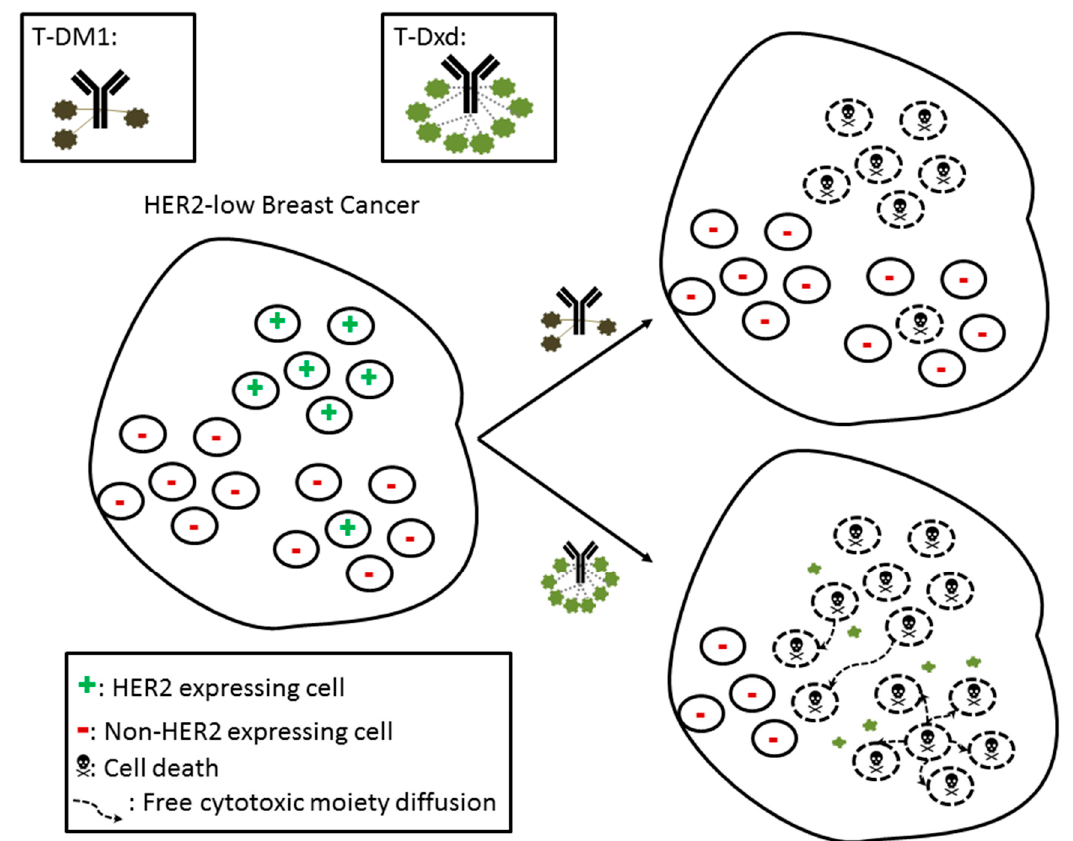
Figure 1. Schematic representation of HER2-low breast cancer being exposed to trastuzumab–emtansine (T-DM1; top of figure), with its non-cleavable linker attaching trastuzumab to the cytotoxic maytansine derivative, and to trastuzumab– deruxtecan (T-Dxd; the bottom of figure), with its cleavable linker attaching trastuzumab to the diffusible, cytotoxic exa- tecan derivative. While DM1 is trapped inside the trastuzumab-targeted cells, Dxd is freely diffusible and able to kill non- expressing HER2-cells. Ultimately, the bystander killing effect represented here explains the success of T-Dxd (and also of trastuzumab–duocarmazine) in targeting HER2-low tumours, despite their lower degree and heterogeneity of HER2 ex- pression.